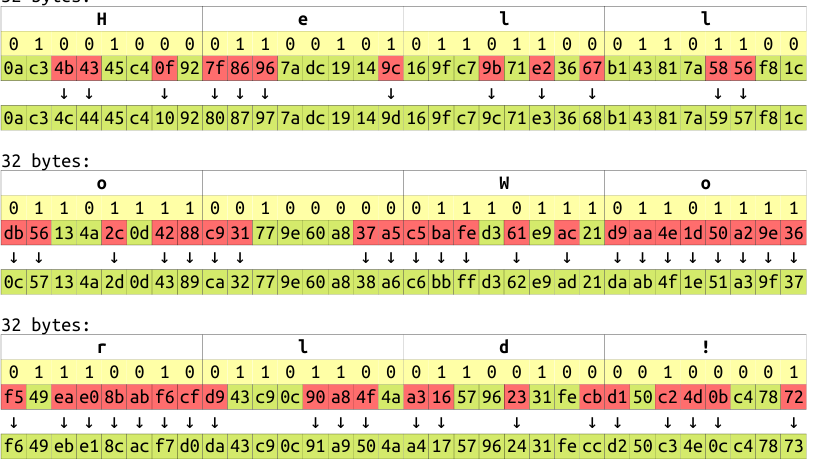
Figure 5. Example of videostego embedding. The hidden message is “Hello world!” (white boxes). Yellow boxes show message bits, red boxes indicate required bit flipping, and green boxes depict resulting